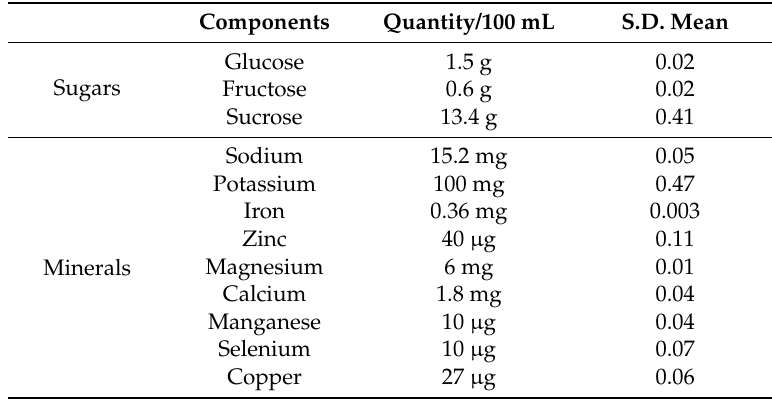
Table 3. The sugar profile and mineral composition of coconut Neera.